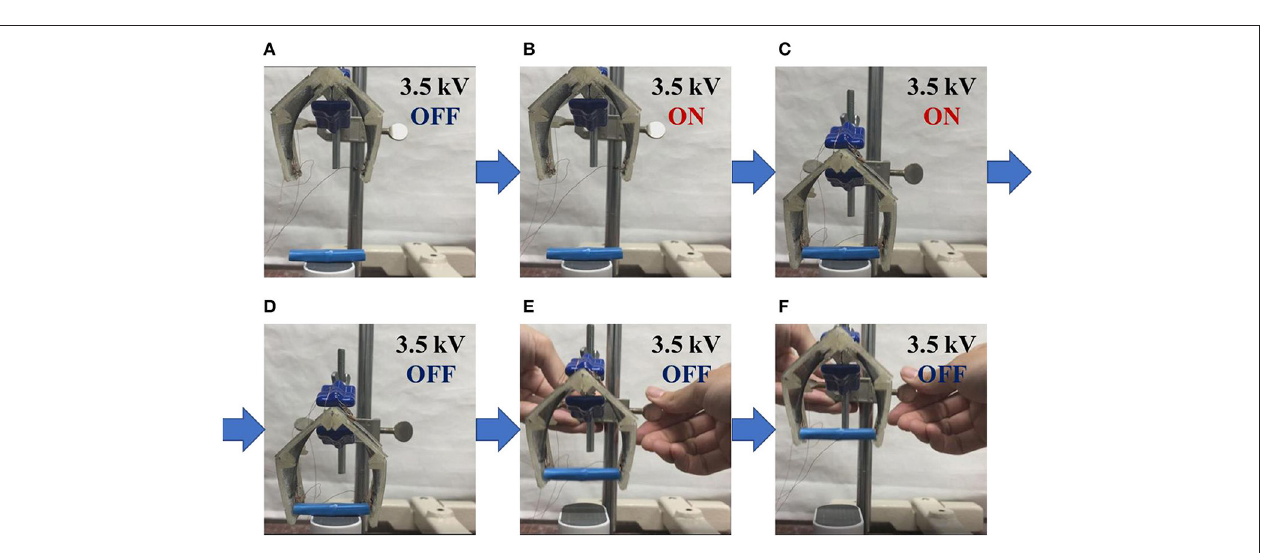
FIGURE 18 | Demonstration to grip an object. The gripper achieves in gripping the object by switching the voltage. (A) Initially, the gripper is closed. (B) When voltage is applied, the gripper opens. (C) Move the open gripper closer to the object. (D) When the voltage is turned off, the gripper grips the object. (E,F) The object can be lifted by moving the